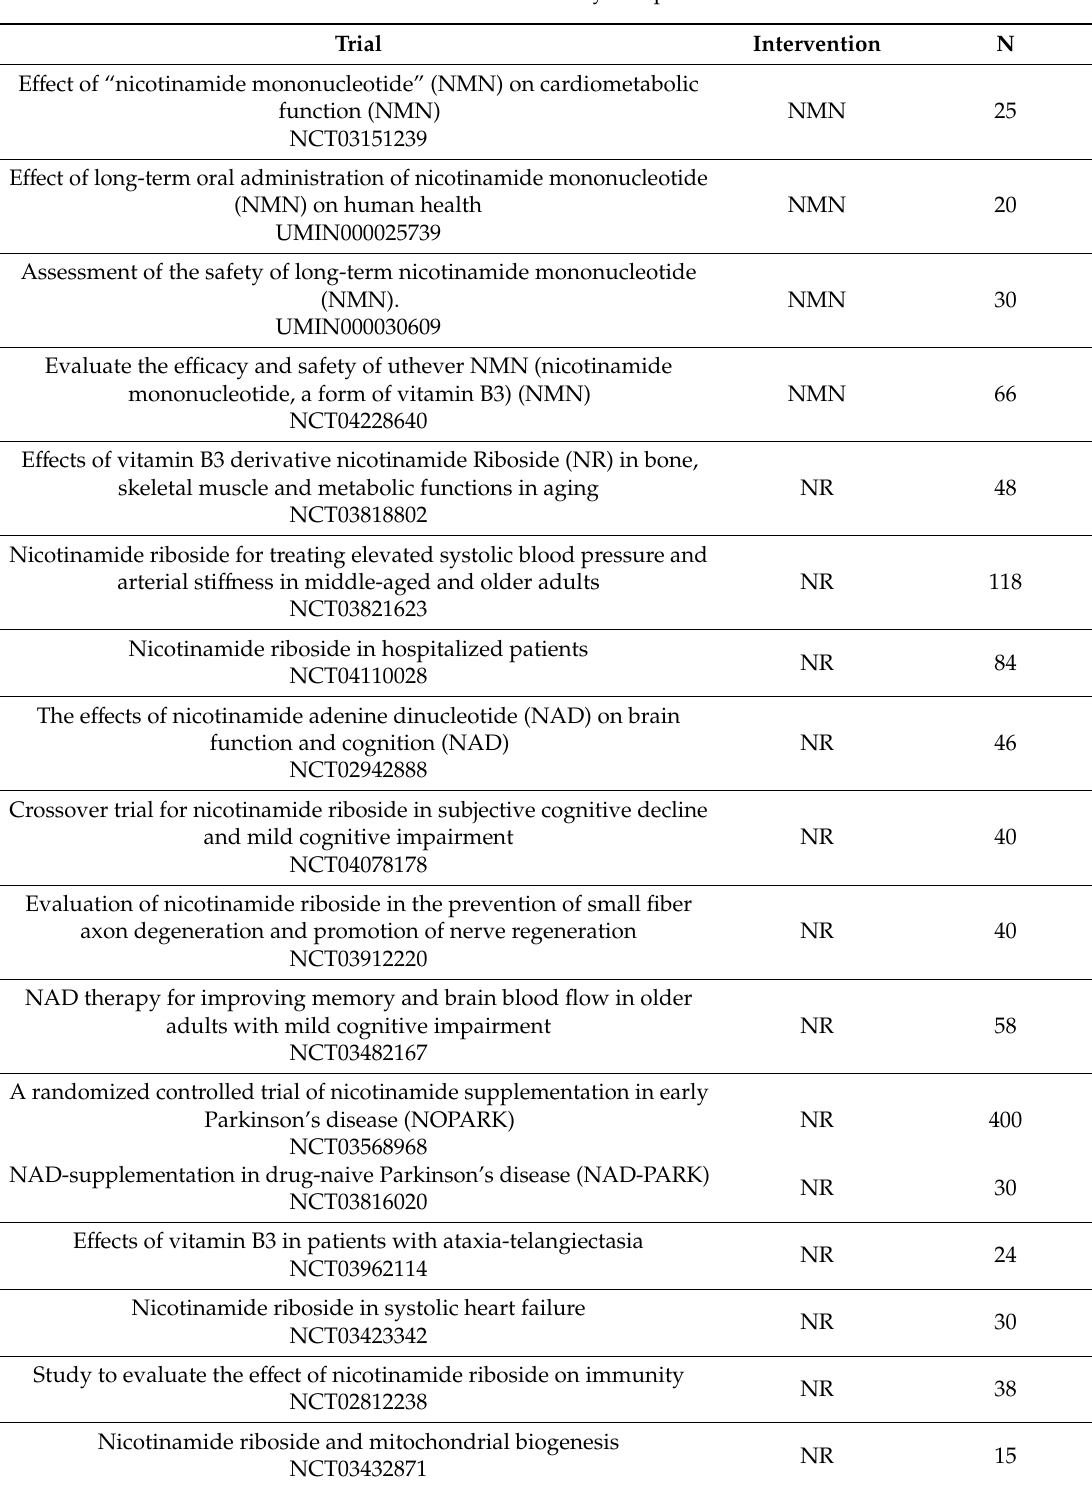
Table 2. Selected clinical trials yet to publish